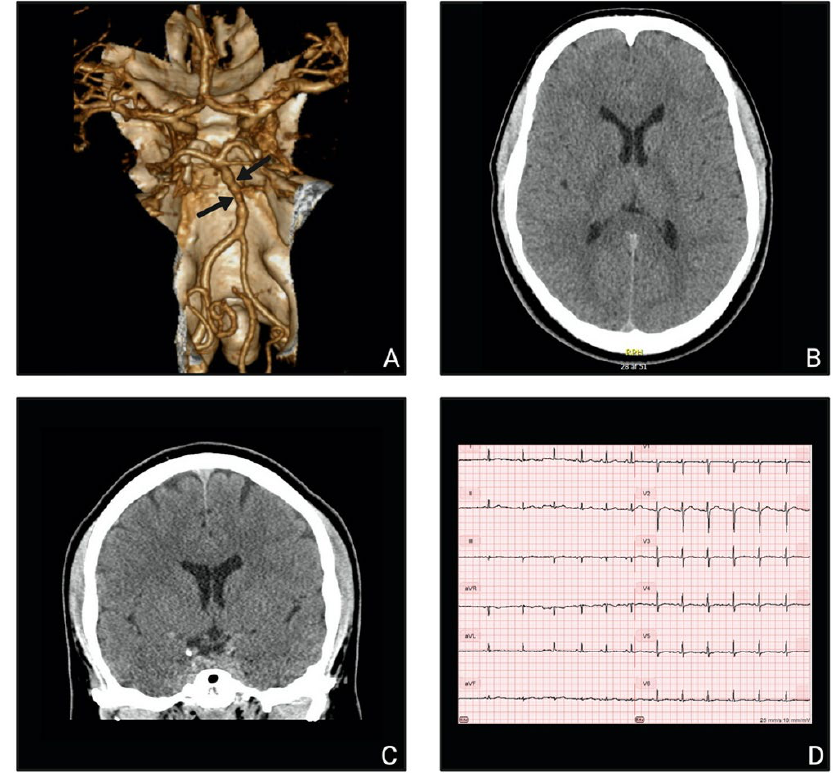
Figure 1. Paraclinical investigations: ( A ) CT angiography three-dimensional reconstruction from 2018 showing alternating segments of the basilar artery with constriction and dilation (“sausage on a string” appearance); ( B , C ) normal CTC-scans from 2021 in the transversal plane ( B ) and the coronal plane ( C ); ( D ) normal ECG from 2021.